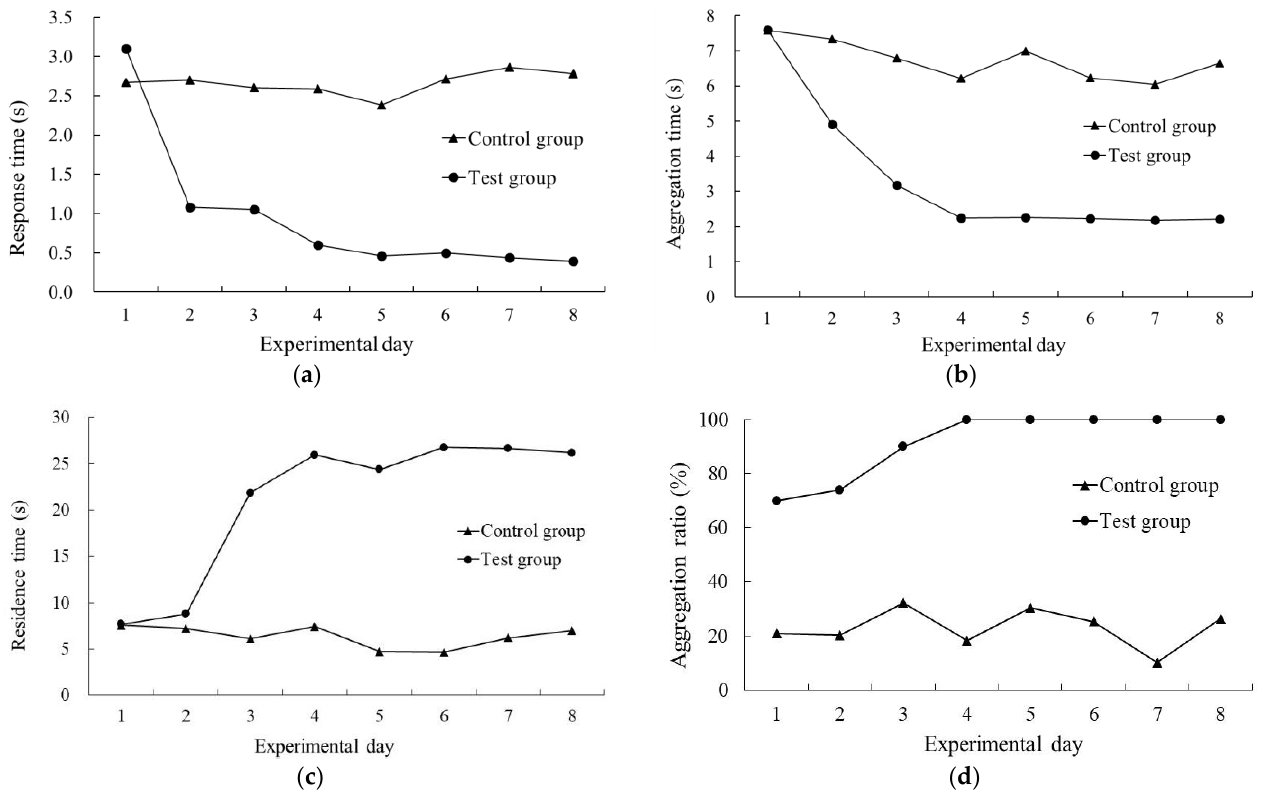
Figure 9. Changes in the response time ( a ), aggregation time ( b ), residence time ( c ), and aggregation rate ( d ) of juvenile Pagrus major trained with 400 Hz square-wave continuous tones from the 1st day to the 8th day.